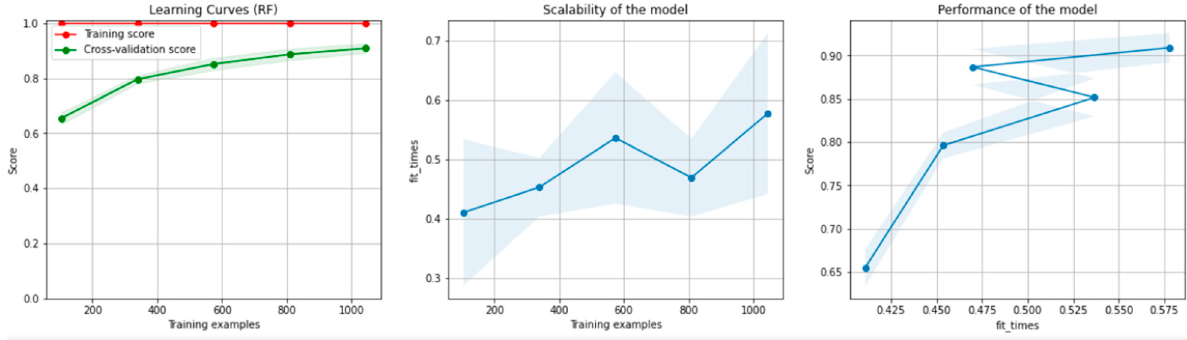
Figure 8. Learning curves, model scalability and model performance for the Gradient Boosting Tree algorithm, for the non-overlapping dataset.